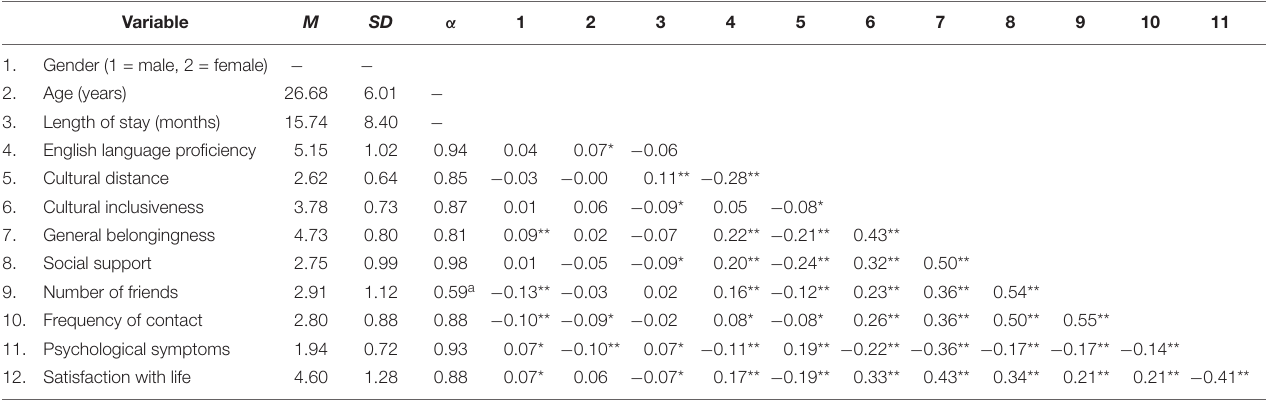
TABLE 1 | Descriptive statistics and